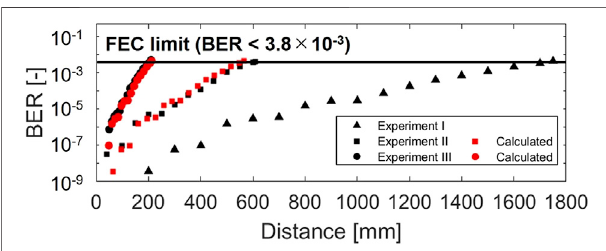
FIGURE 9 | BER characteristics in each transmission experiment. The red squares and red circles depict the calculated characteristics obtained from the experiment I data. The calculations were based on Friis ’ s formula, considering the extra link losses shown in Table 2 .